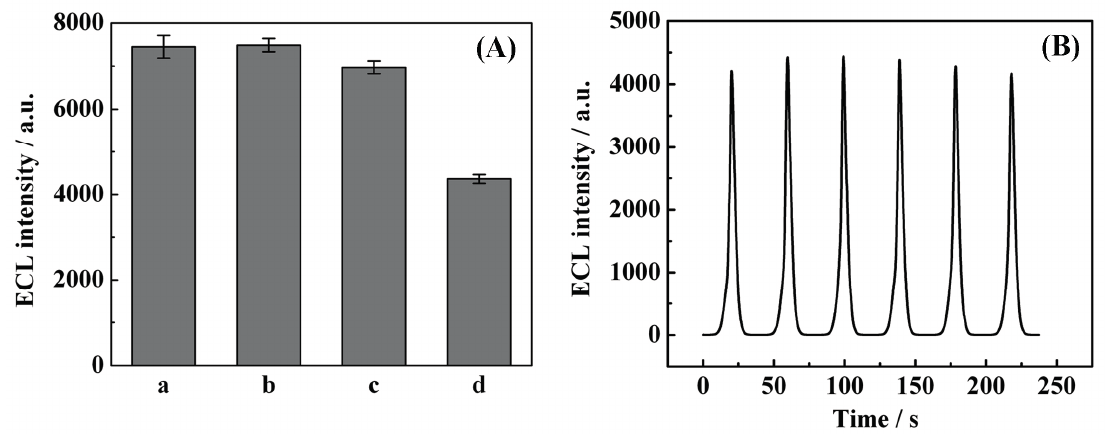
Figure 6. Selectivity and stability of the modified electrodes. ( A ) Selectivity for the target DNA against nDNA and sDNA was investigation: (a) blank solution (0 pM target DNA); (b) 100.0 fM nDNA; (c) 100.0 fM sDNA; and (d) 10.0 fM target DNA, the experiments were repeated 3 times (error bars = SD, n = 3); ( B ) ECL profiles of the sensor for 10.0 fM target DNA with 6 continuous CV cycles.